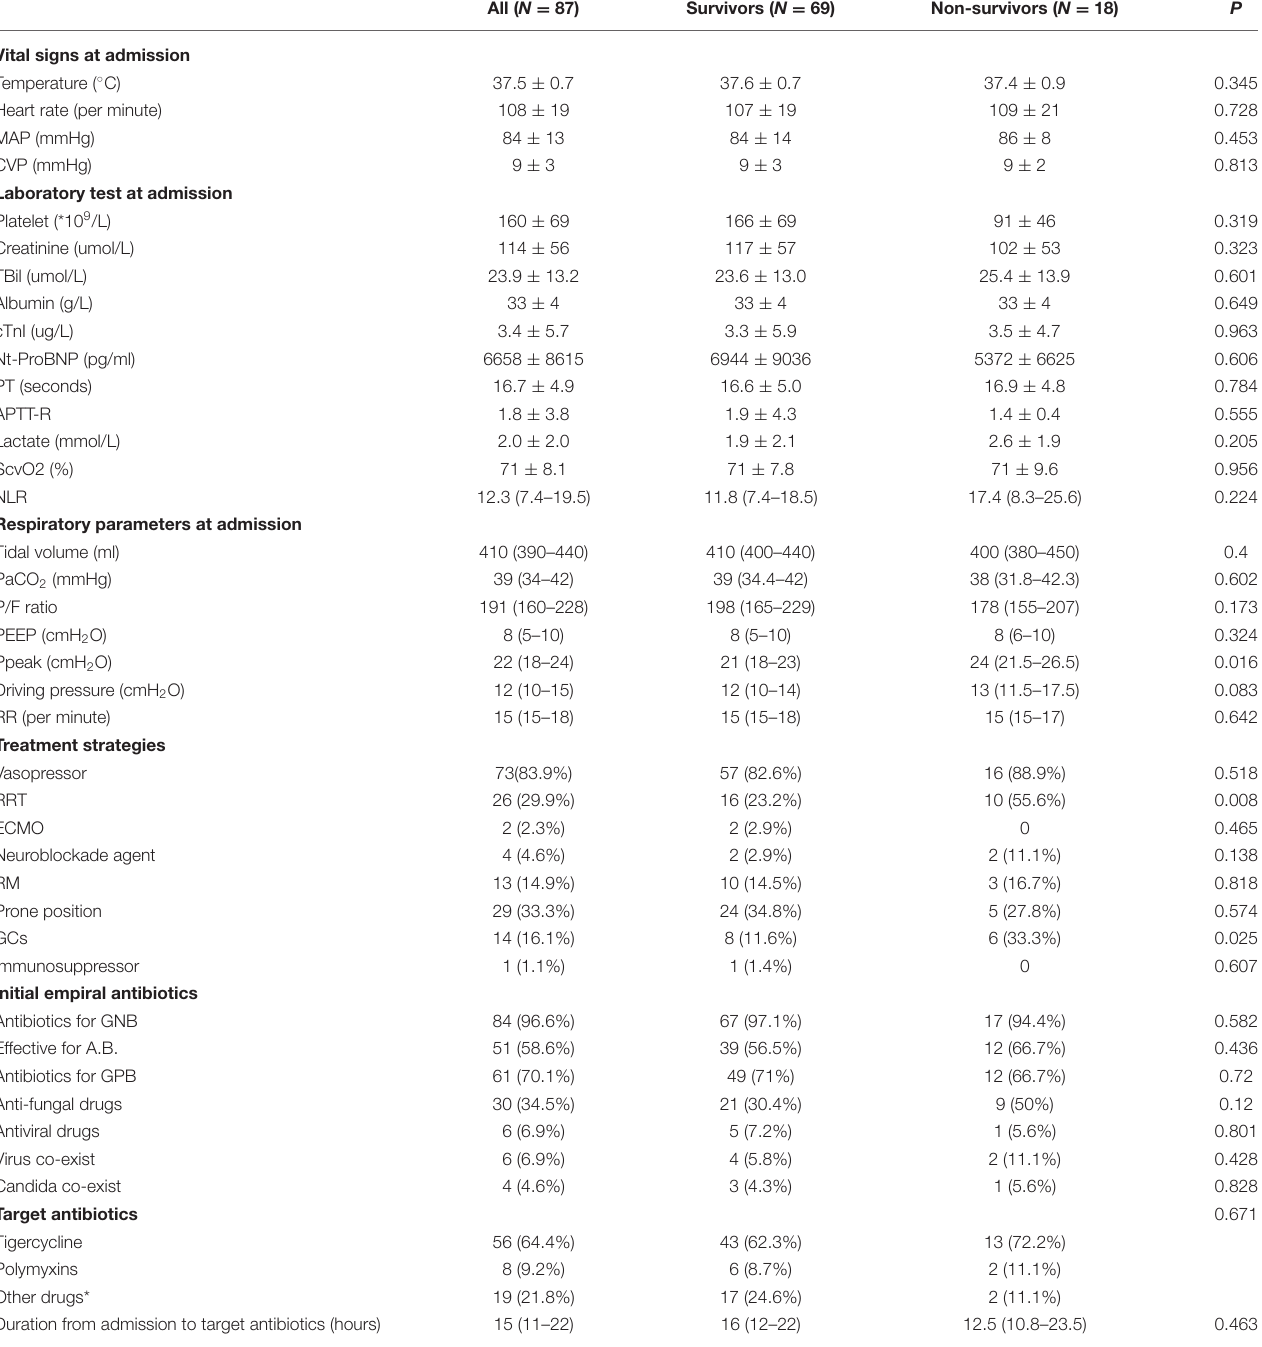
All ( N = 87) Survivors ( N =